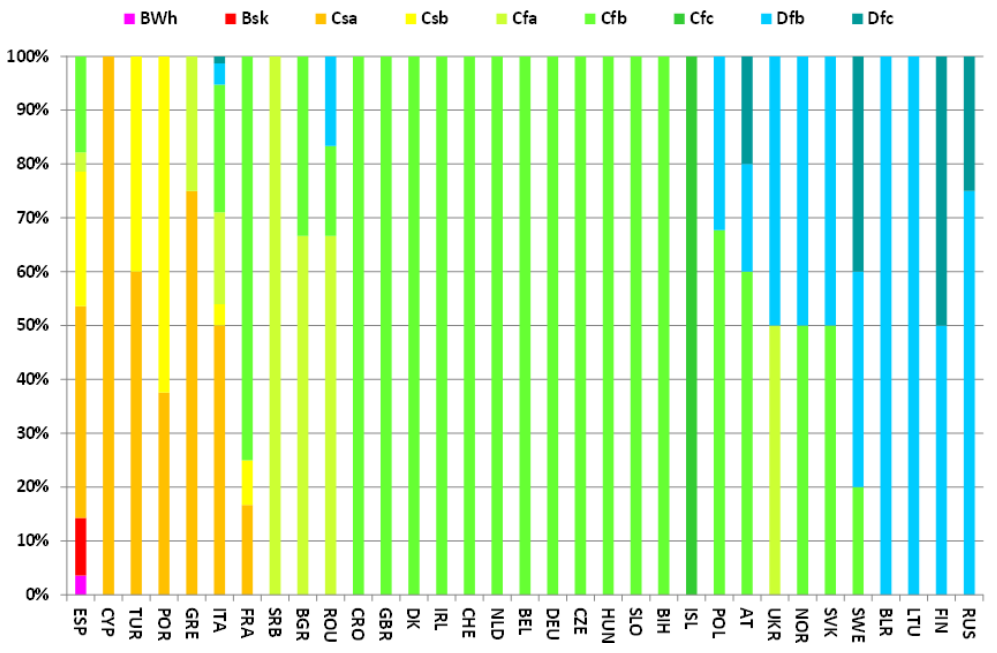
Figure 5. Subdivision of climate conditions based on the Köppen-Geiger scale for the selected locations in Europe.